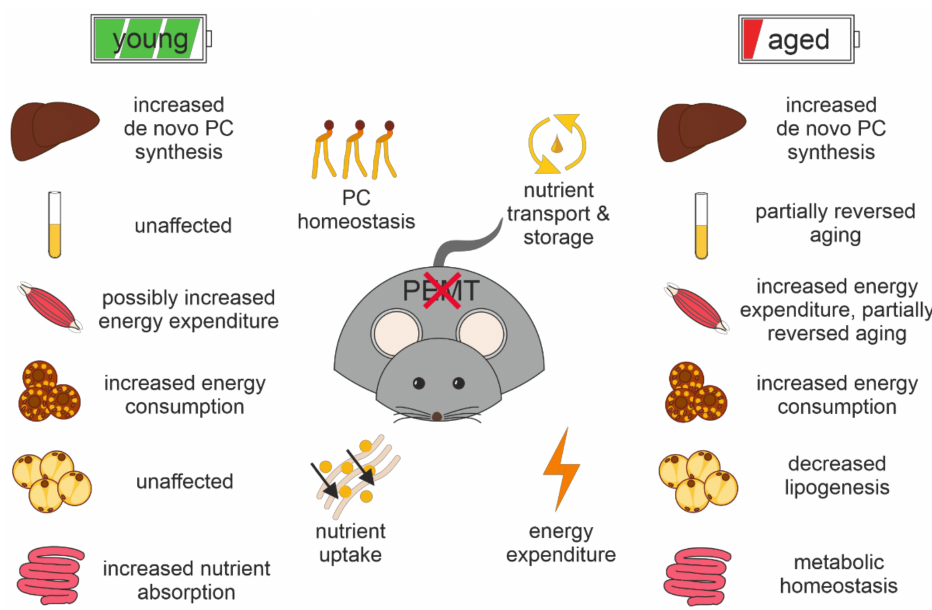
Figure 10. Summary of the key findings from untargeted metabolomic investigation of PEMT KO mouse